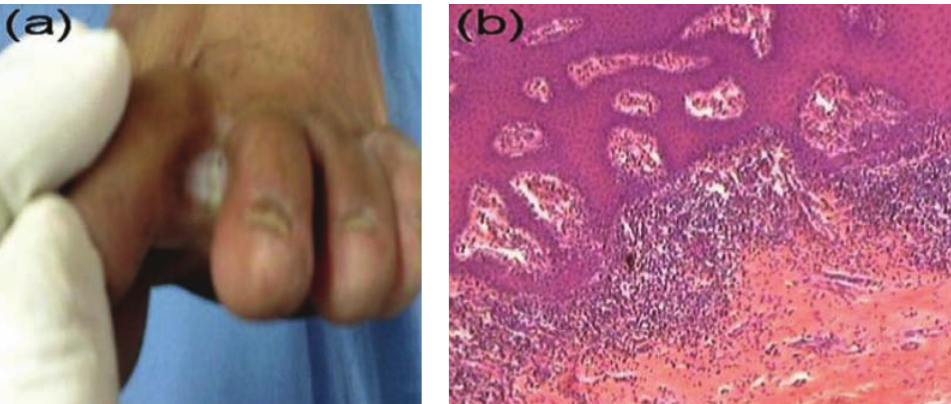
Figure 5: Interdigital lichen planus. (a) Interdigital whitish plaque with well-defined border. (b) The biopsy shows acanthosis, band-like lymphocytic infiltrate in the papillary dermis and vacuolar alteration of basal cell layer (H&E, ×